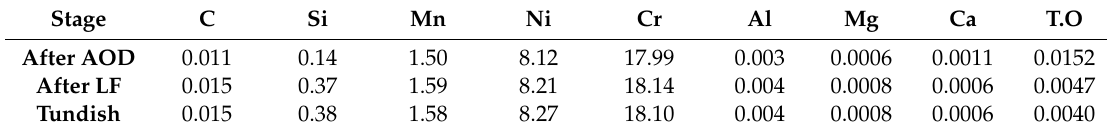
Table 1. Chemical composition of 304L at different stages (mass fraction %).